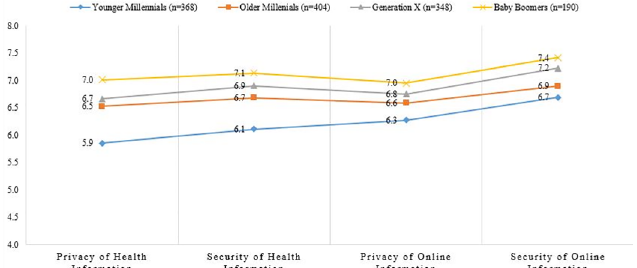
Fig 2. Concern about privacy & security of general online vs. health information. YoungerMillennials 18–27 years old, Older Millennials28–35years old, Generation X 36–51 years old, Baby Boomers